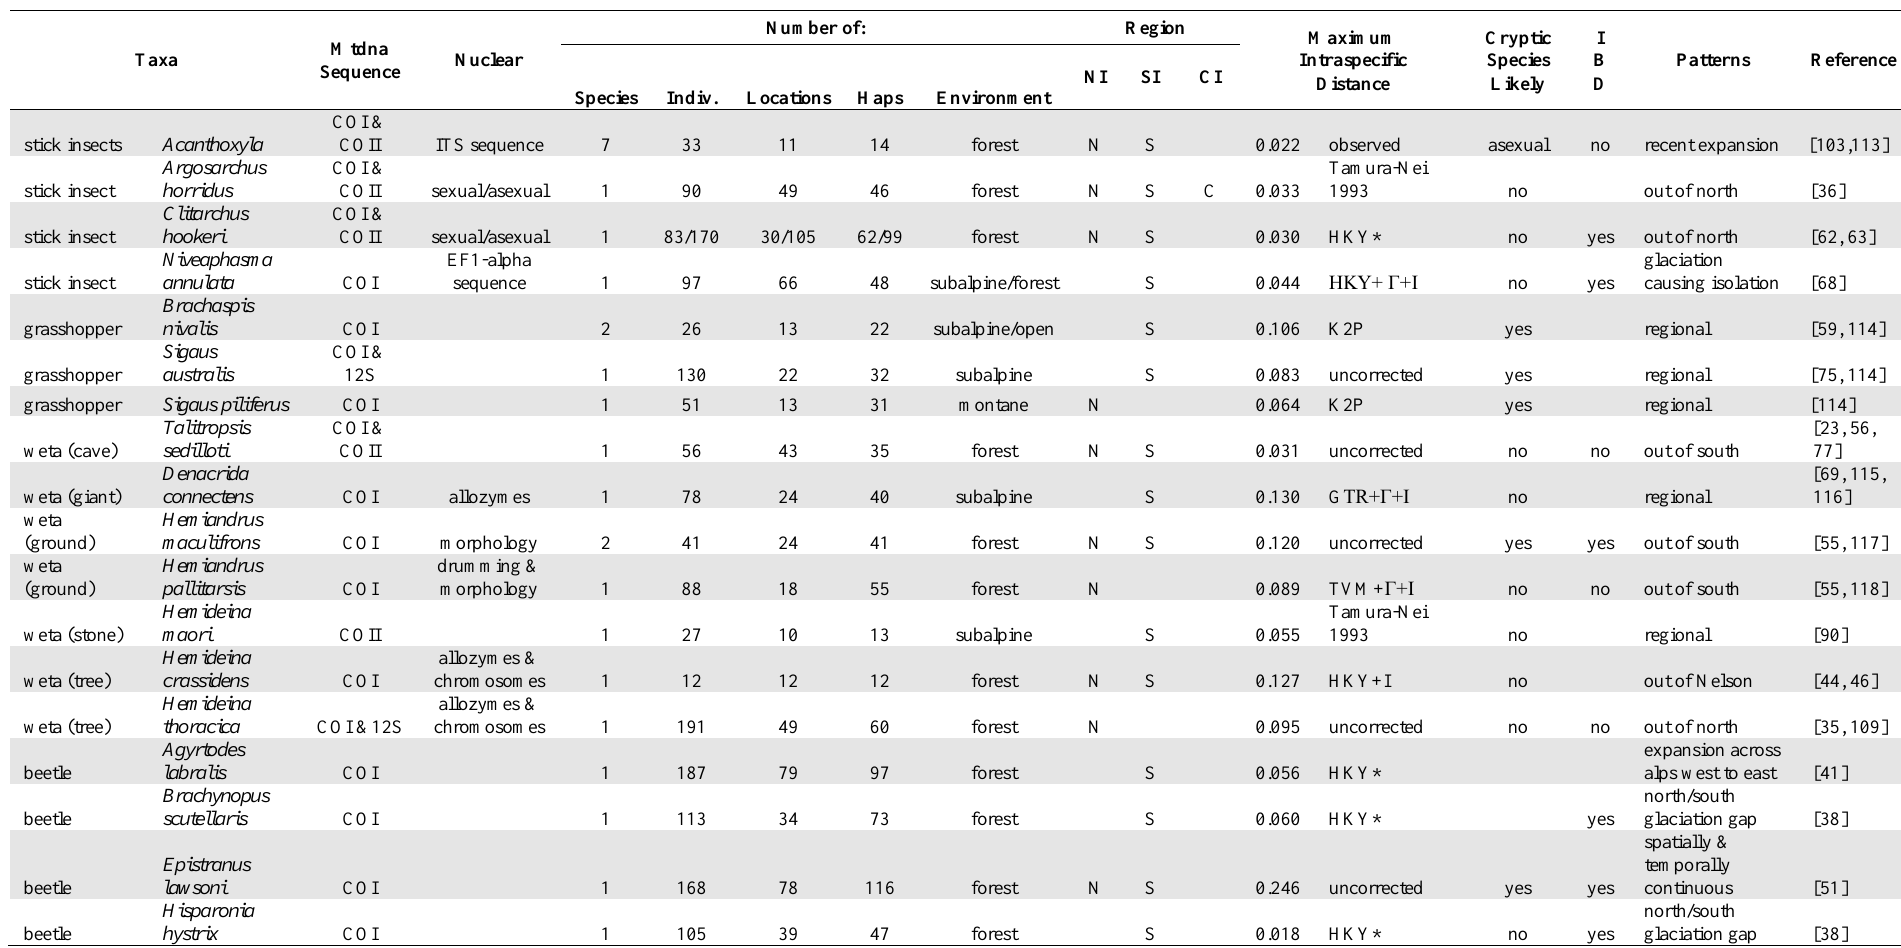
Table 3. Intraspecific phylogeographic studies of New Zealand invertebrates. Pairwise distances calculated for taxa marked with * using HKY ( Hasegawa, Kishino & Yano) from Genbank accessions using Geneious Pro v5.3.4. [112]. Numbers: Indiv.- individuals, Haps.- haplotypes. Regions: N-North Island, S-South Island, C-Chatham Islands. IBD- isolation by distance inferred from correlation between geographic and genetic distance (in most studies a Mantel test was